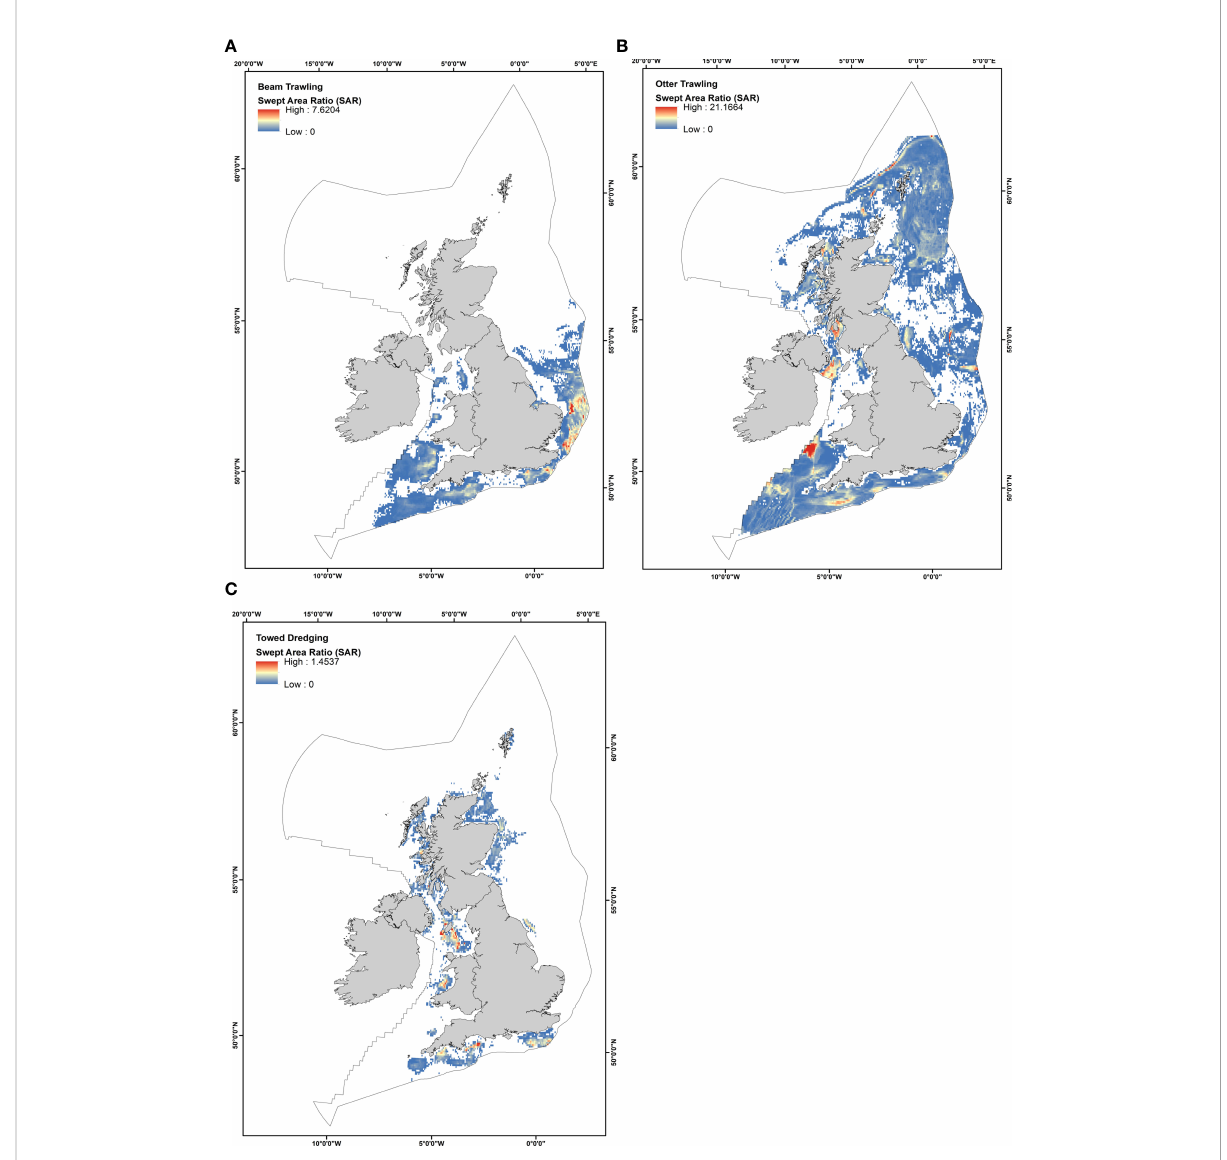
FIGURE 4 The average swept area ratio (SAR) within the UK EEZ between 2009 2017 for (A) Beam Trawling, (B) Otter Trawling, (C) Towed Dredging, and (D) All Fisheries (Beam, Otter, Dredge, and